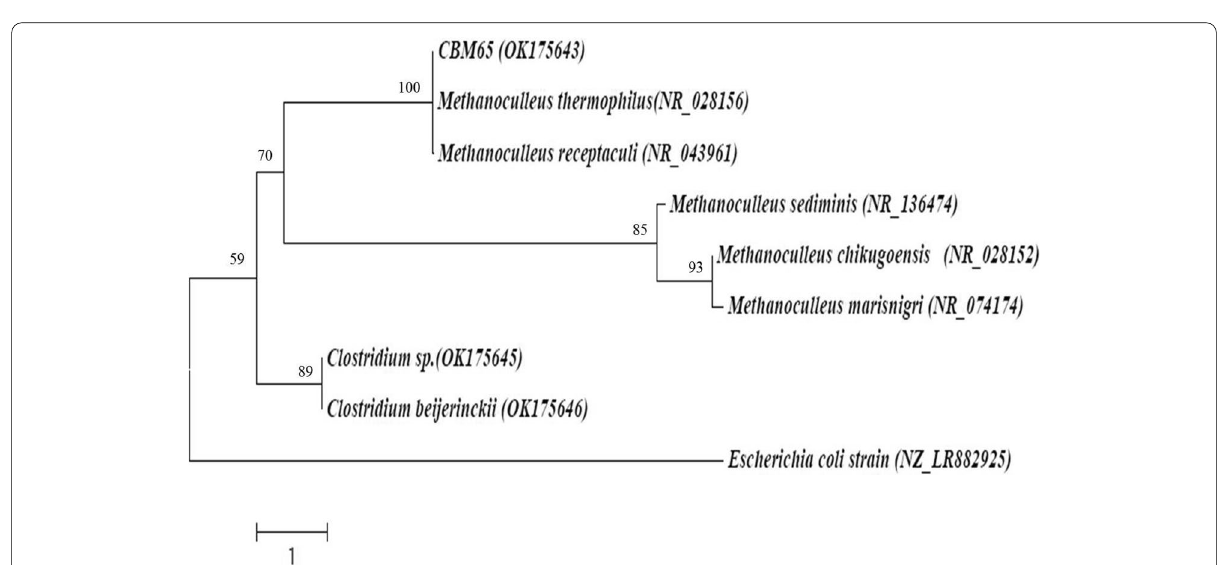
Fig. 6 The phylogenetic tree of the consortium was constructed using neighbor-joining. The tree topologies were estimated with 1000 bootstrap data sets. The tree shows the relationship within the archaeal and bacterial domain. GenBank accession numbers are provided in brackets. The scale bar indicates sequence